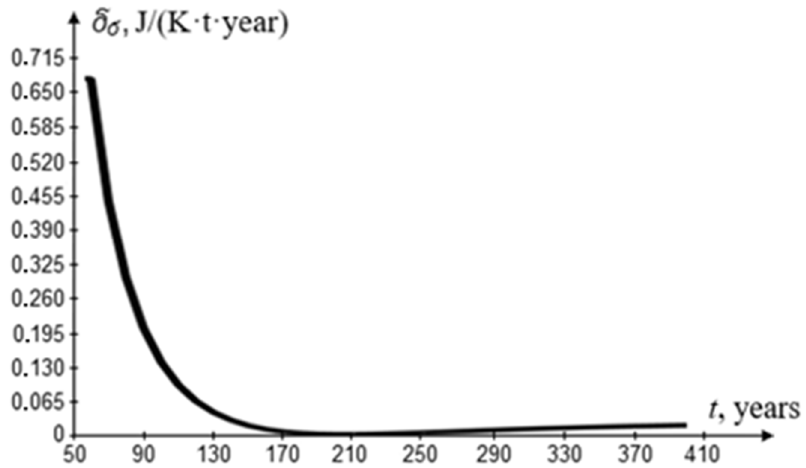
Figure 1. Dependence of the effective specific entropy production on time for a single-tree stand. The Y-axis shows the effective specific entropy production δ _ σ (t) in J/(K t year). The X-axis shows time in years.